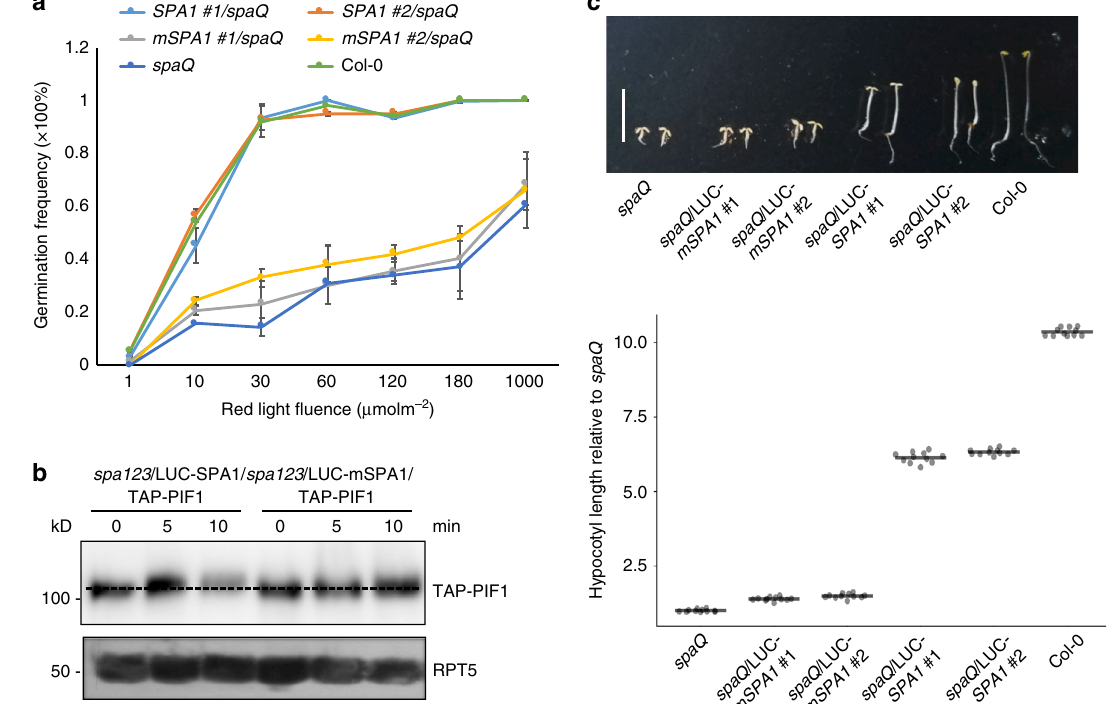
Fig. 3 The kinase activity of SPA1 is necessary for its biological function. a Seed germination phenotypes of wild type and mutant SPA1 expressed in the spaQ background in response to an increasing fl uence of red light. Col-0 and spaQ were used as controls. Homozygous transgenic plants expressing similar levels of wild type and mutant SPA1 were selected. Error bars indicate s.e.m. ( n = 3). b Immunoblots showing the phosphorylation and degradation of TAP- PIF1 in spa123 seedlings expressing either the wild type or the mutant form of LUC-SPA1. c (top) Photograph showing the seedling phenotypes of two independent lines of wild type LUC-SPA1 and LUC-mSPA1 expressed in spaQ background grown in darkness for 4 days. The mutant LUC-mSPA1 failed to complement the short hypocotyl phenotype whereas the wild type LUC-SPA1 largely complements the phenotype. (Bottom) Dot plot shows the hypocotyl lengths of seedlings shown in the top panel. Scale bar = 5 mm. Line = median, ( n =